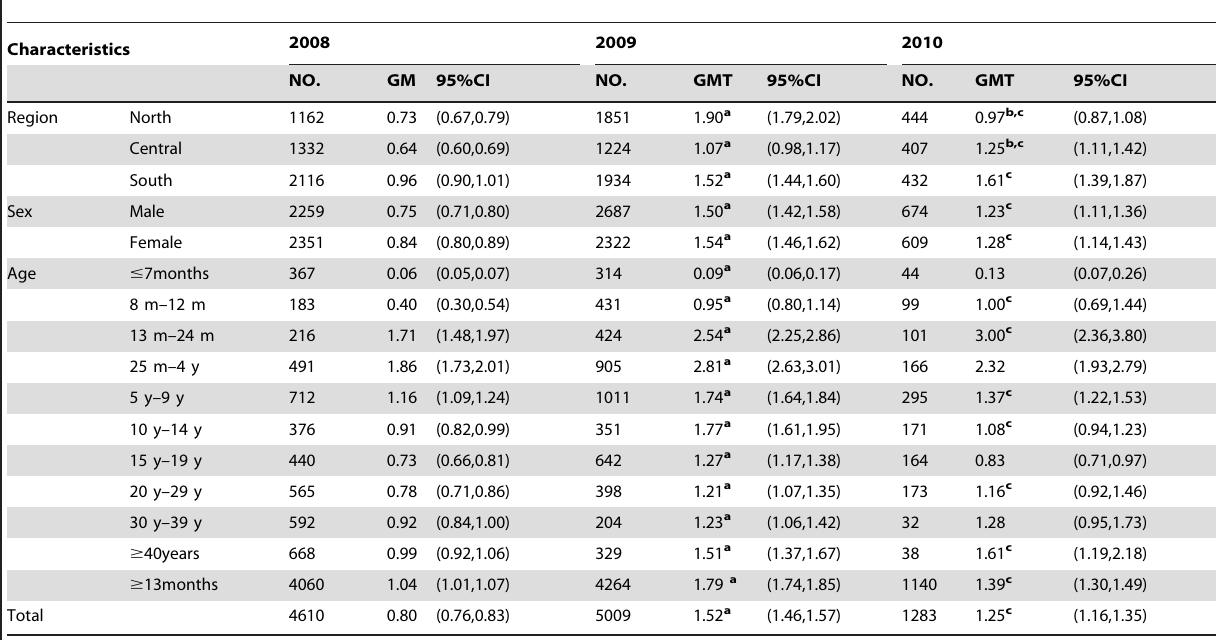
Table 1. GMT of measles antibodies by region, sex, and age groups in the Jiangsu province, 2008–2010(IU/ml).